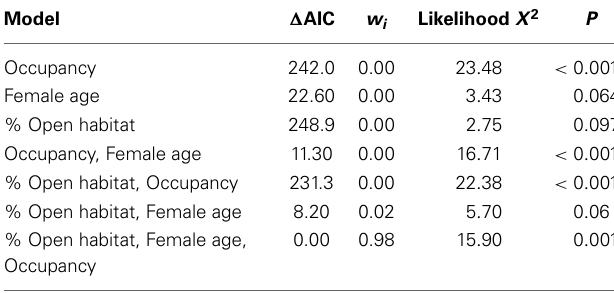
Table 2 | Model selection of the significant variables that influence reproductive success in the eastern bluebird population of western